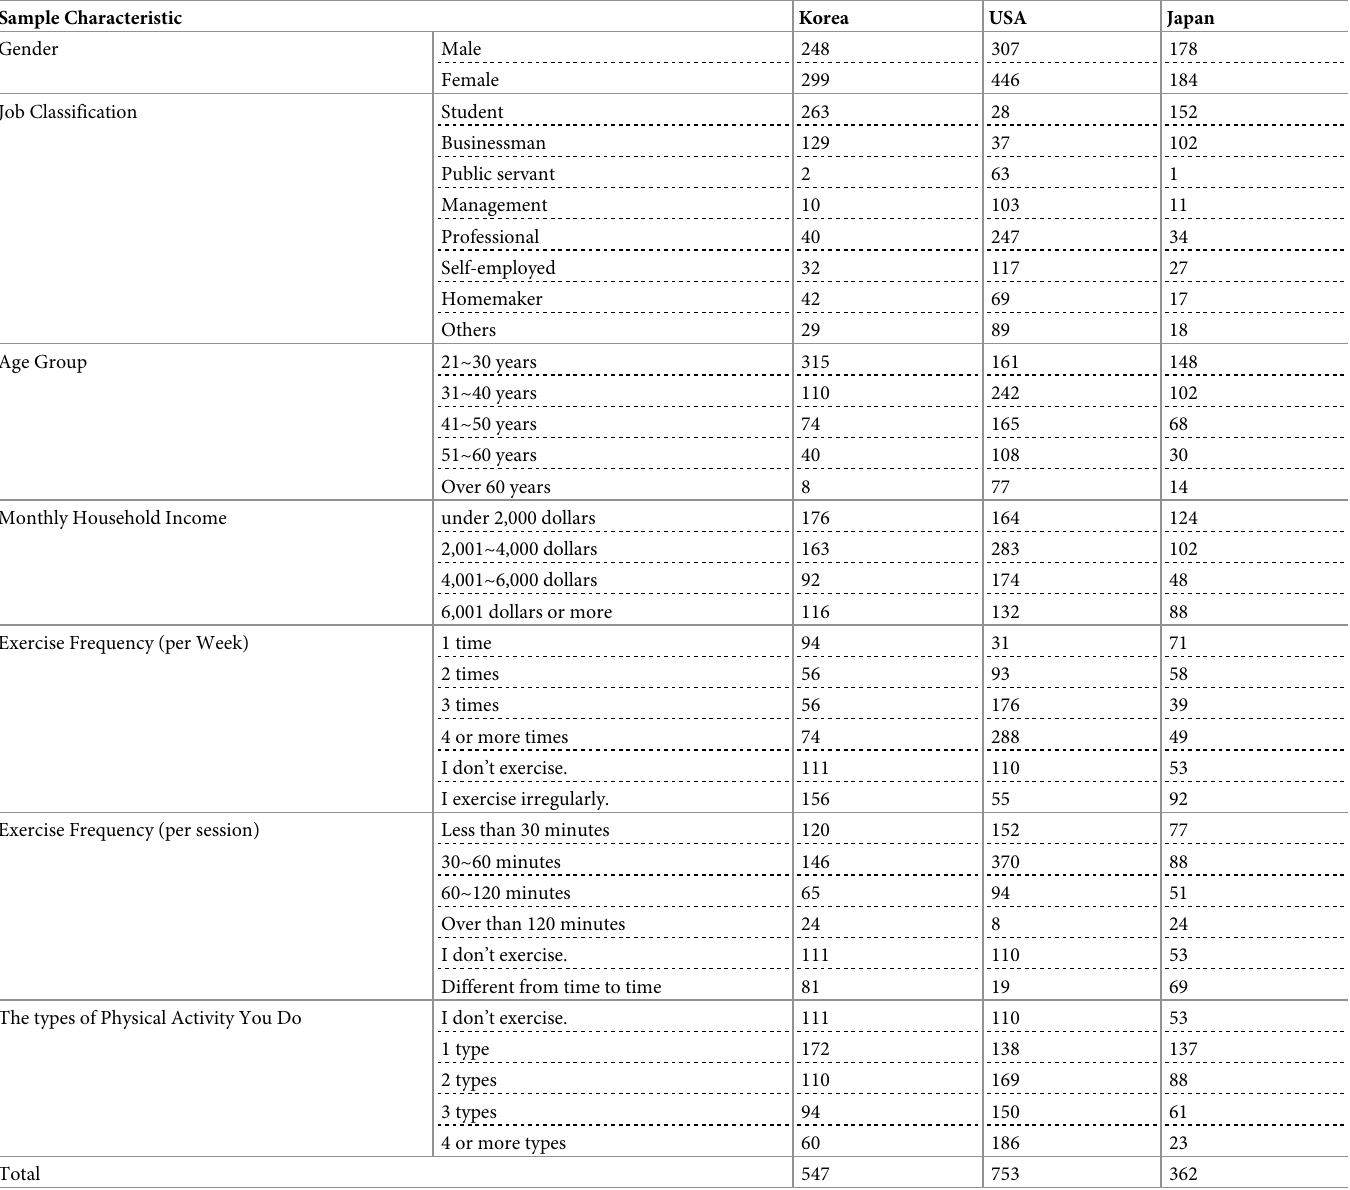
Table 4. Sample characteristic (actual physical